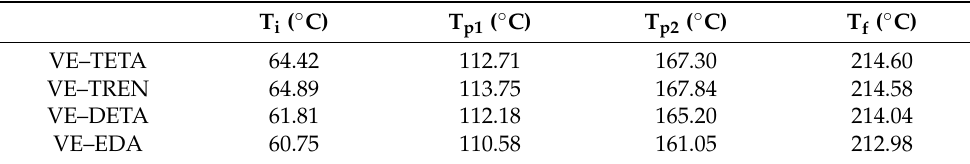
Table 2. Characteristic temperatures from DSC studies of the curing